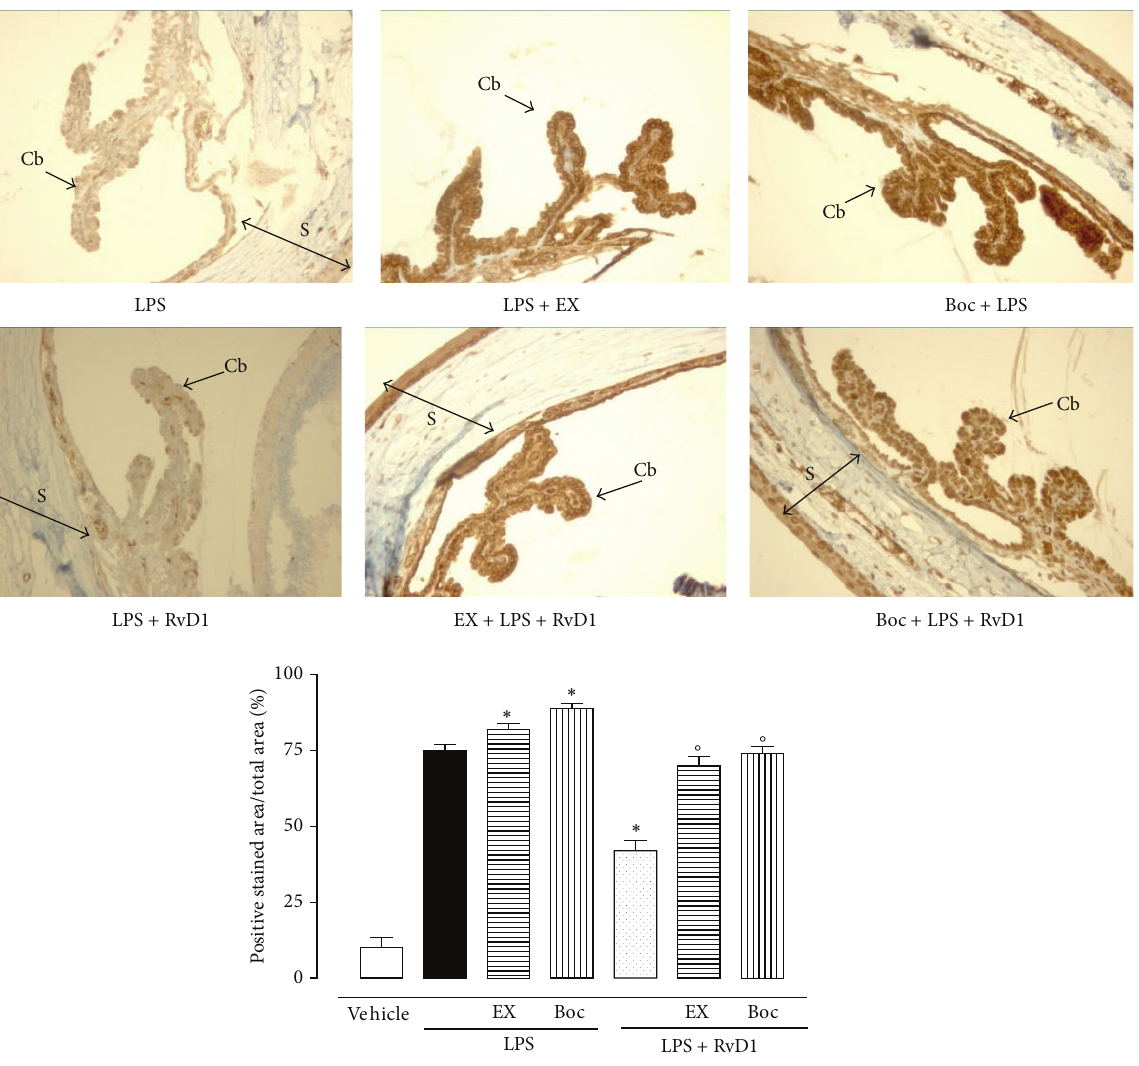
∗∗ ∗ ∘ ∘ Figure 5: Representative immunohistochemistries of ocular tissues showing FOXO1 following LPS alone; LPS + RvD1 (1000ng/kg); EX-527 + LPS + RvD1 (1000ng/kg); Boc2 + LPS + RvD1 (1000ng/kg). As shown by the percentage of stained area per total area analyzed, RvD1 decreased FOXO1 expression. The addition of EX-527 and Boc2 increases the expression of FOXO1 with respect to LPS alone, while they decrease the expression of this factor if administered prior to LPS + RvD1 (1000ng/kg). Values are mean ± S.E.M. of 𝑛 = 6 observations for each group. ∗ 𝑃 < 0.05 and ∗∗ 𝑃 < 0.01 versus LPS-treated group, while differences versus LPS + RvD1 1000 ng/kg are indicated as ∘ 𝑃 < 0.01 . CB = ciliary body; S = sclera; EX = EX527; Boc = Boc2; RvD1 = resolvin